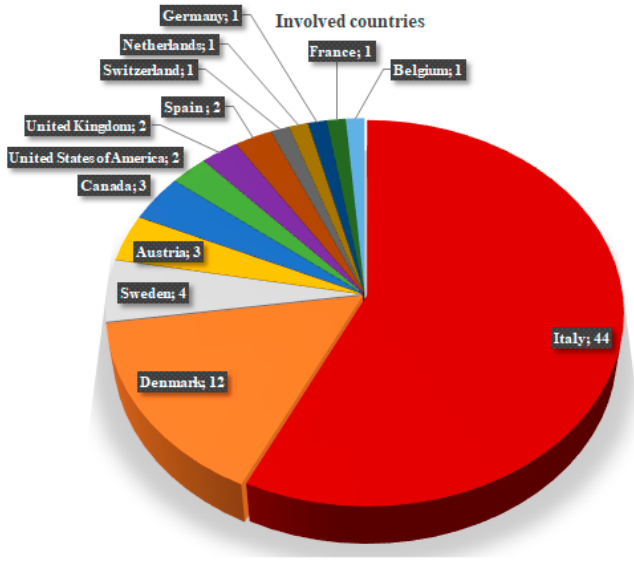
Figure 2. Number of participants from each country.